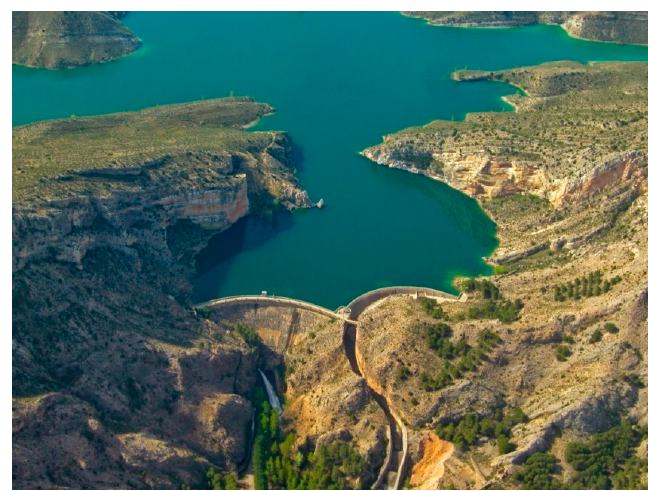
Figure 2. Aerial view of Cueva Foradada dam and its fixed crest spillway.